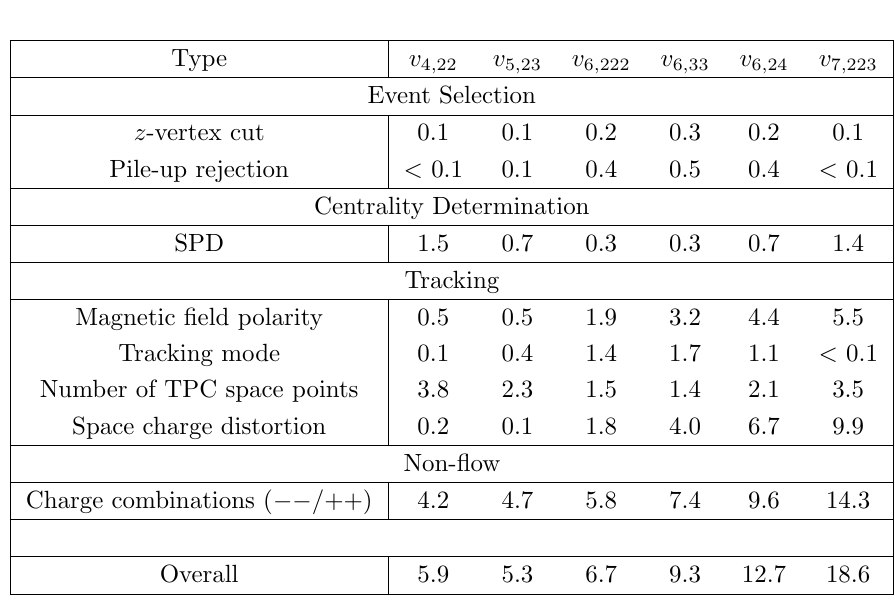
Table 1 . Relative systematic uncertainties of the (cid:13)ow coe(cid:14)cients. The uncertainties are given in percents and are categorized into four groups: event selection, centrality determination, track- ing and non-(cid:13)ow. The overall systematic uncertainty is obtained by summing in quadrature the uncertainties from each source.